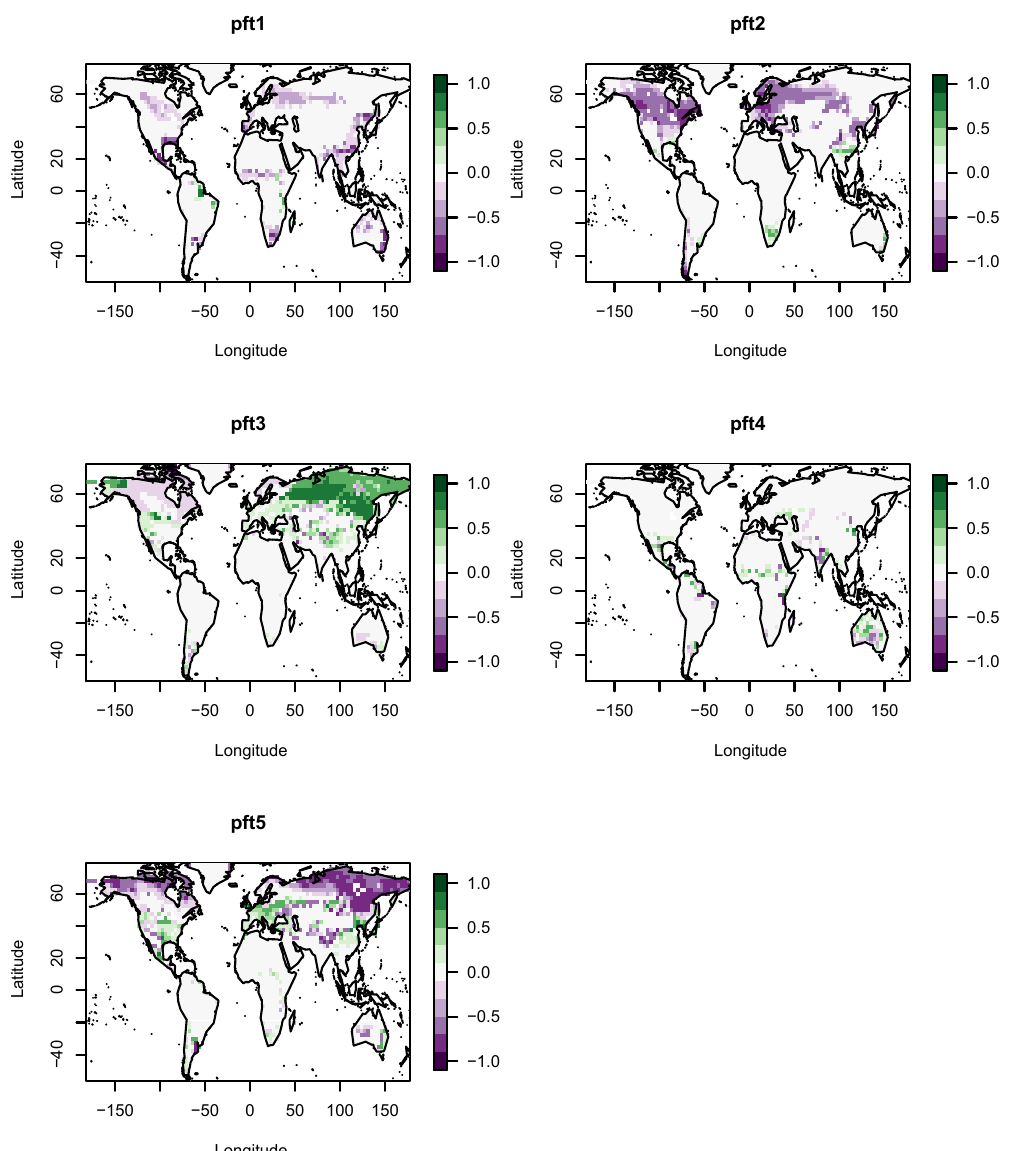
Figure A3. Maps of mean annual anomalies of vegetation cover between LGM and PI in the Dynamic simulations, for the five PFTs: pft1 is broadleaf trees; pft2 is needleleaf trees; pft3 is C 3 grasses; pft4 is C 4 grasses; pft5 is